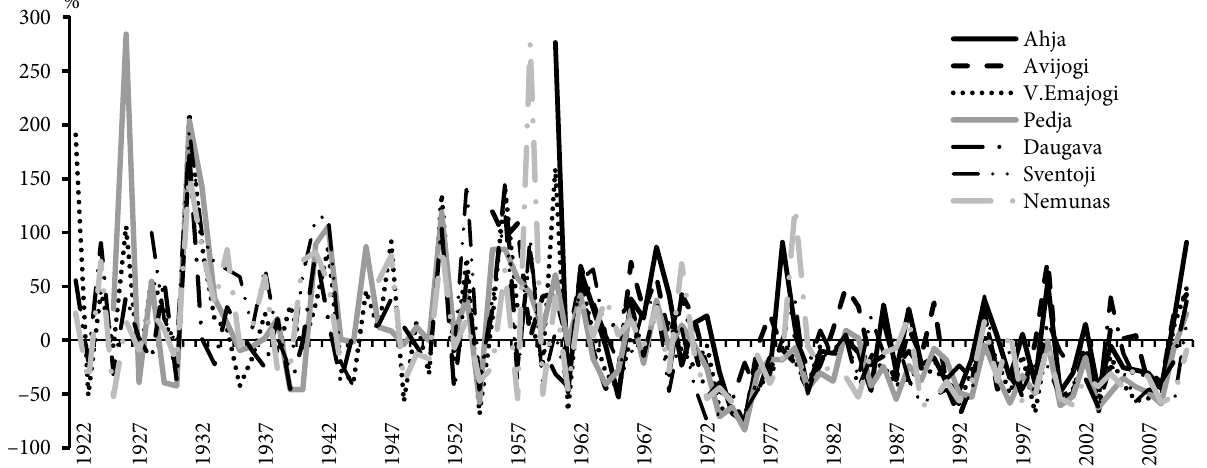
Fig. 2. Annual maximum spring flood anomalies (%) from the long-term average in the continental rivers